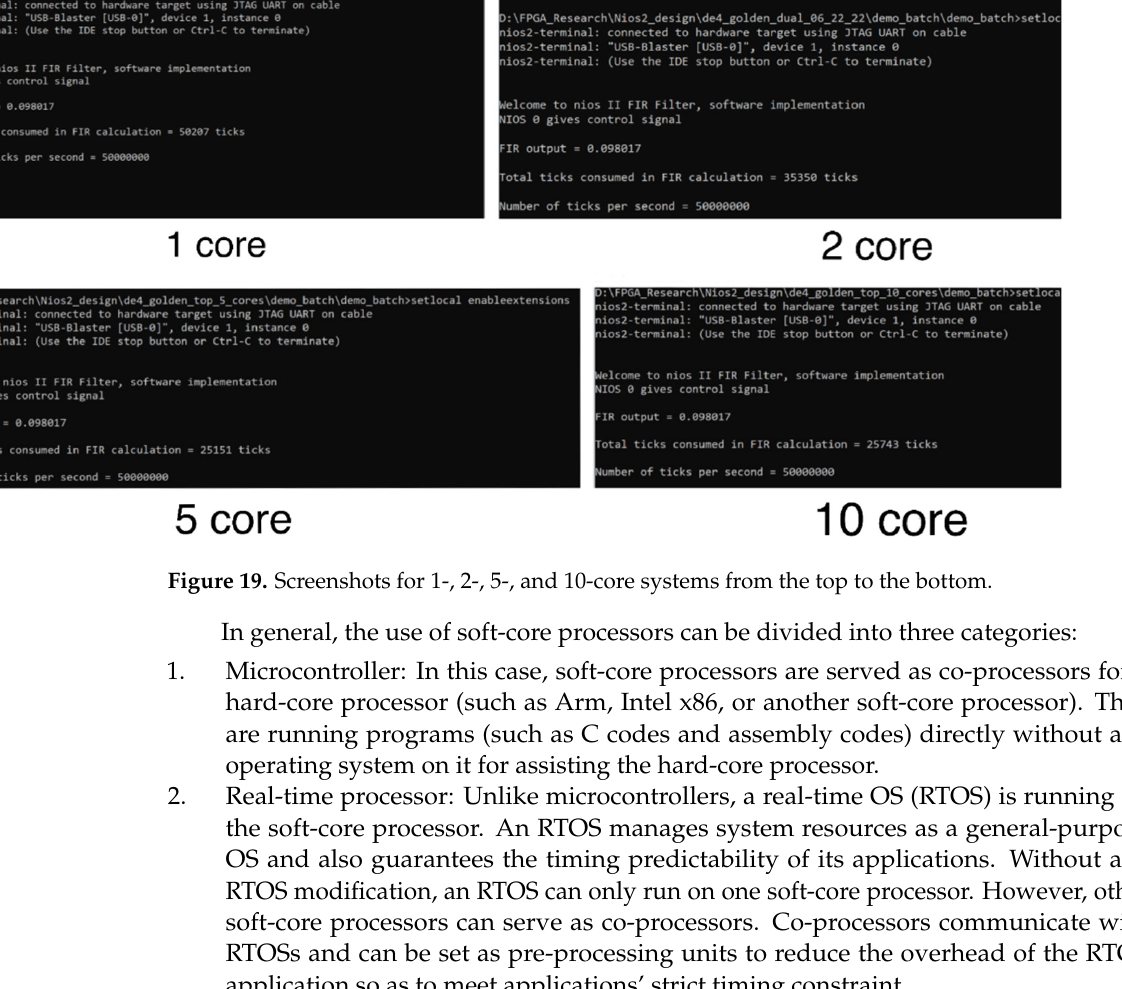
Table 6. Task assignments for each system.